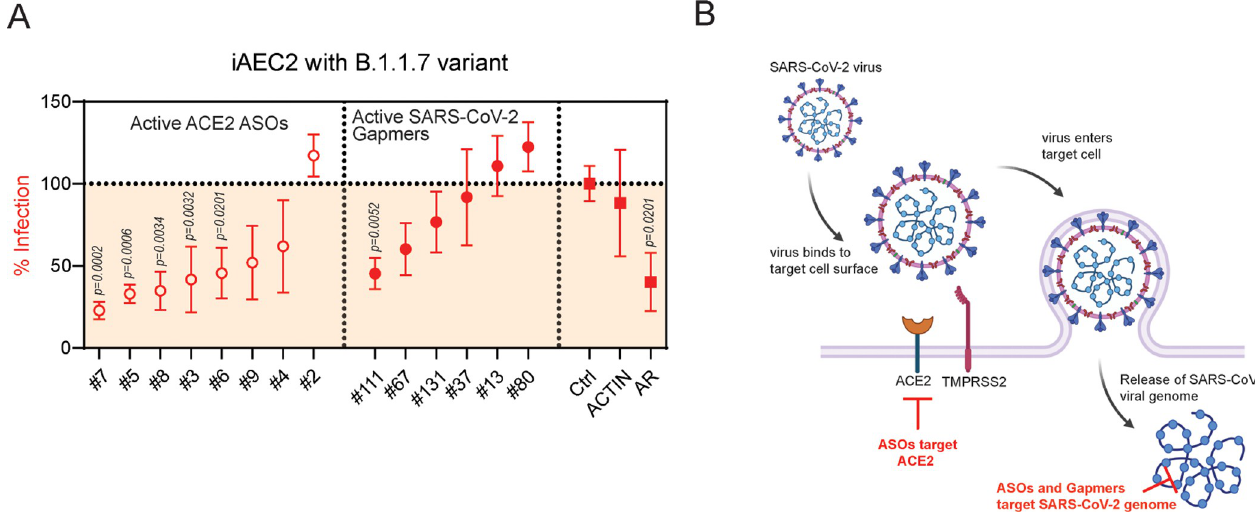
Fig 4. Antiviral activities of ACE2 and SARS-CoV-2 ASOs in iACE2 cells. (A) SARS-CoV-2 bioassay of ACE2 ASOs and SARS-CoV-2 Gapmers in iAEC2 cells against B.1.1.7 strain. P values were calculated using two tailed unpaired t test by comparing to control (Ctrl). (B) Schematic illustration of therapeutic potential of ASOs against SARS-CoV-2